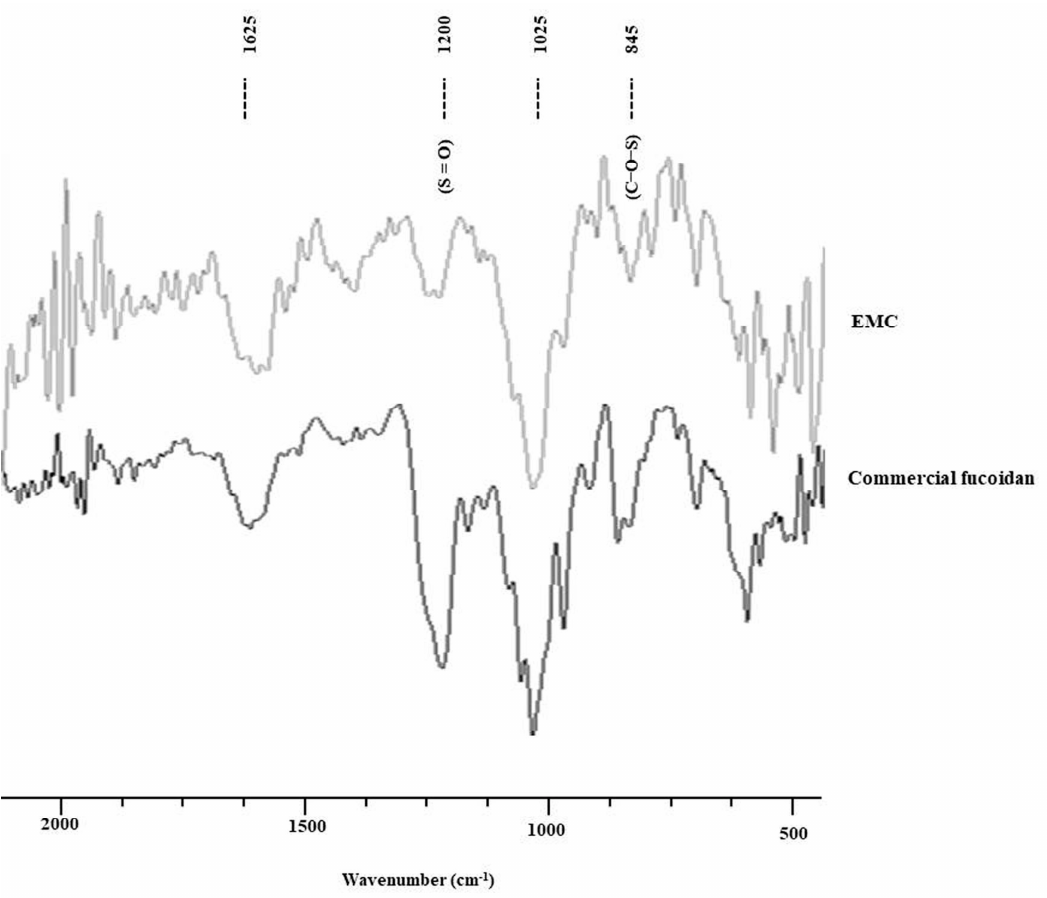
Figure 1. FT-IR spectra of EMC and commercial Figure 1